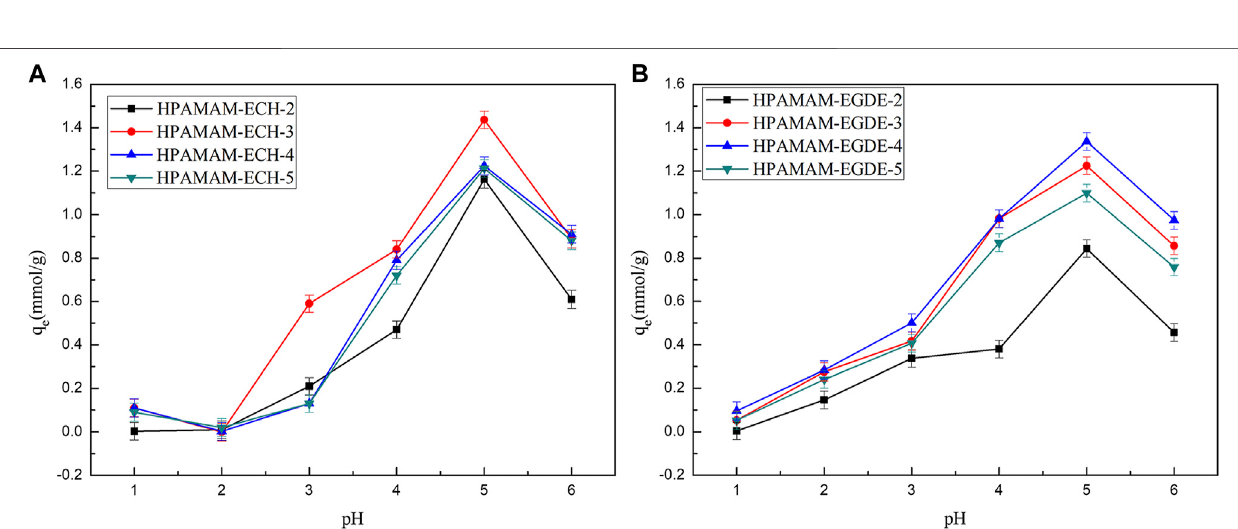
Frontiers in Chemistry |